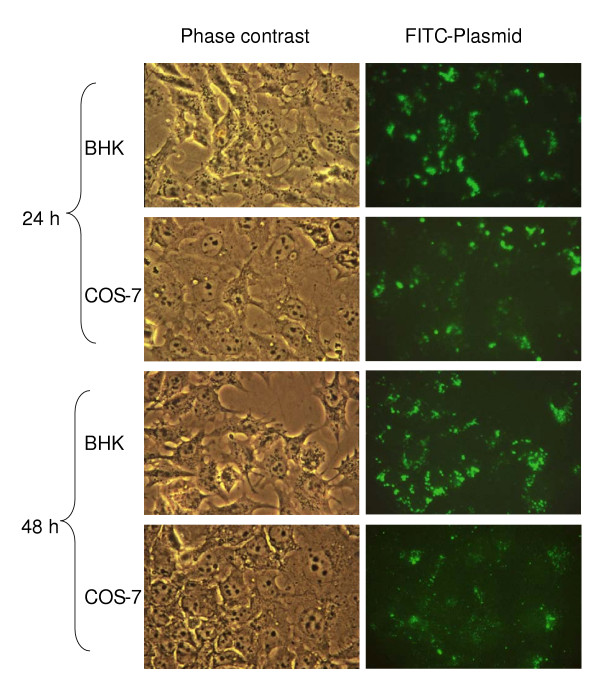
Intracellular processing of complexes. Transfection of BHK or COS-7 cells with FITC labeled R011. Cells were transfected with 0.75 μg of FITC-R011. Cells were fixed at time points indicated and subjected to phase contrast and fluorescence microscopy.